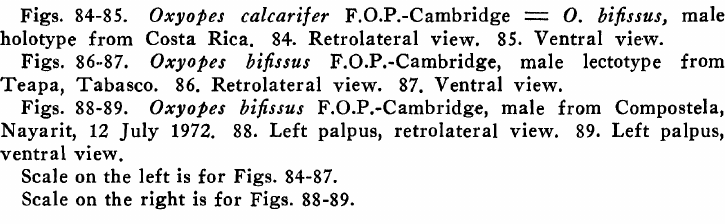
Figs. 84-85. Oxyo#es calcari[er F.O.P.-Cambridge O. bifissus, male holotype from Costa Rica. 84. Retrolateral view. 85. Ventral view. Figs. 86..87. Oxyotses bifissus F.O.P.-Cambridge, male lectotype from Teapa, Tabasco. 86. Retrolateral view. 87. Ventral view. Figs. 88-.89. Oxyoles bifissus F.O.P.-Cambridge, male from Compostela, Nayarit, 12 July 1972. 88. Left palpus, retrolateral view. 89. Left palpus, ventral view. Scale on the left is for Figs. 84-87. Scale on the right is for Figs.